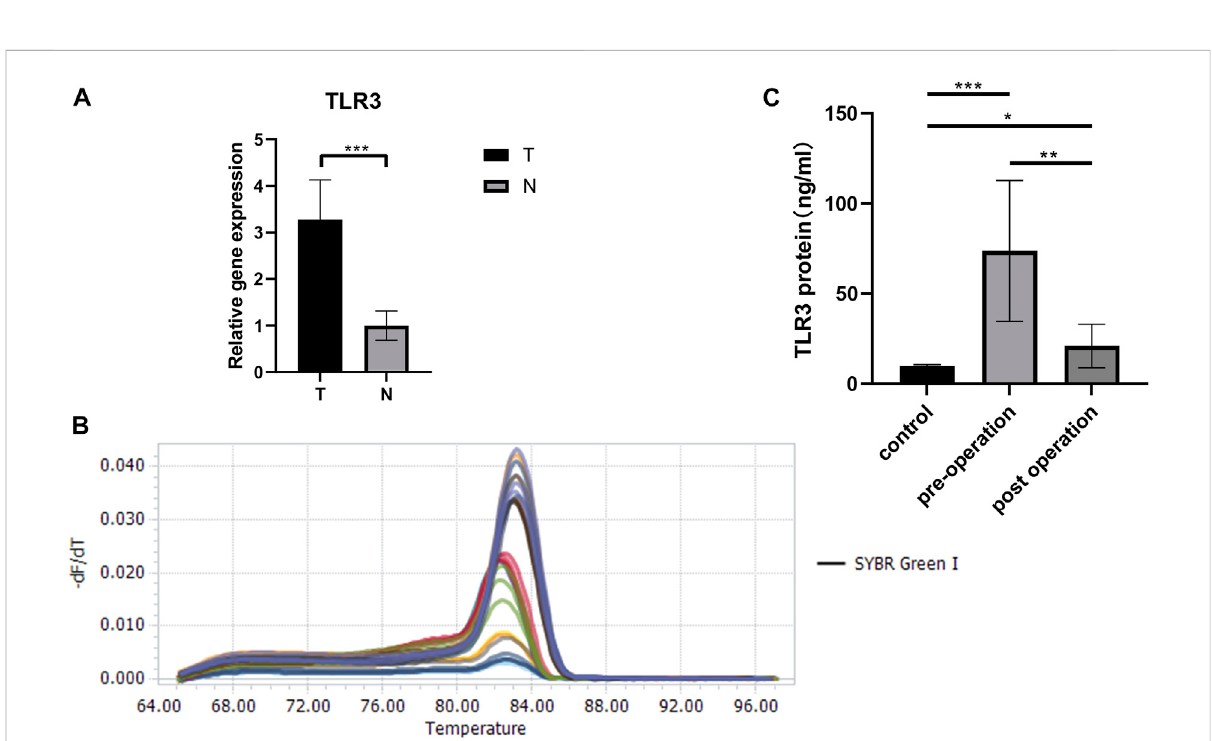
FIGURE 9 The results of RT-qPCR and ELISA. (A) The expression levels of TLR3 mRNA in early stage of KIRC tissues and adjacent normal tissues. (B) The melting peaks of RT-qPCR. (C) Comparison of TLR3 protein levels in plasma of patients with early KIRC before operation, 3 days after operation and healthy adults. T: KIRC tissues; N: adjacent normal tissues; control: healthy adults; * p < 0.05; ** p < 0.01; *** p <